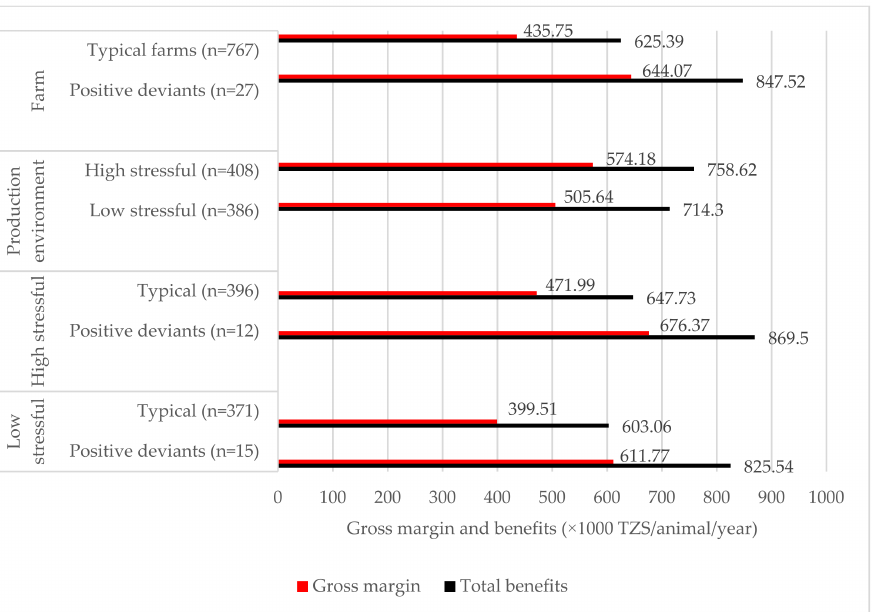
Figure 3. Gross profit margins and total benefits from dairy cattle on positive deviant and typical farms nested within production environments (Exchange rate 2297.5295 TZS = 1